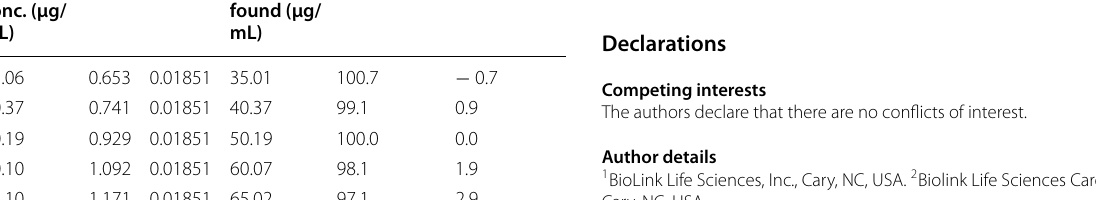
Table 6 Risk of an inaccurate result as a function of concentration calculated using the response factor for the 50 μg/ ml working standard (limit 10% difference) Actual conc.